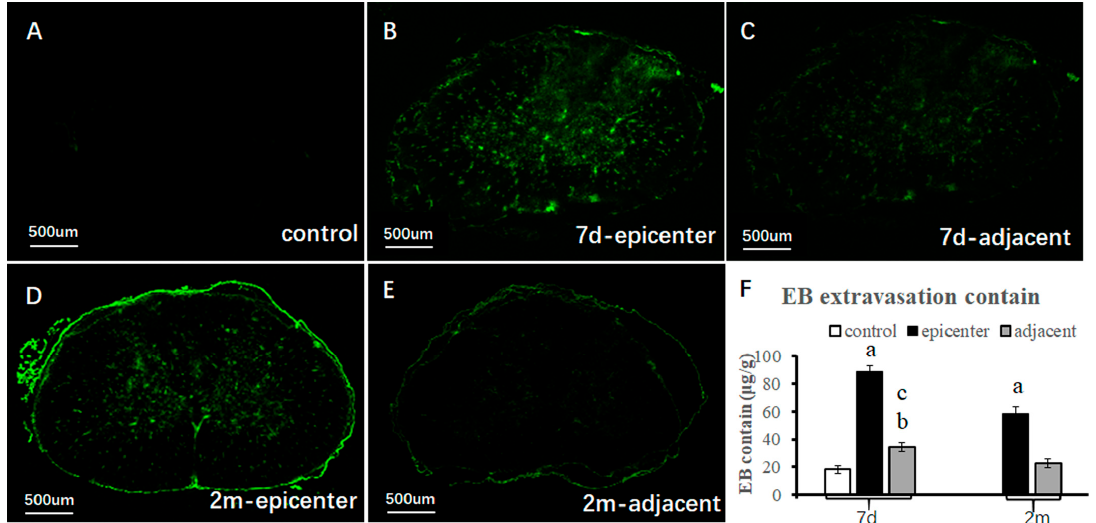
Figure 6. Disruption of BSCB integrity. ( A ) Negative EB fluorescence in control group. ( B ) EB fluorescence widely spread into the GM of the compressive epicenter at the 7th day. ( C ) Obvious decreased EB fluorescence in adjacent level at the 7th day. ( D ) Decreased EB fluorescence in the compressive epicenter at the 2nd month. ( E ) Significantly decreased EB fluorescence in adjacent level at 2nd month. ( F ) EB extravasation content increased significantly in the epicenter and adjacent level at the 7th day, while it decreased at the 2nd month. No significant difference was found between the adjacent level at 2nd month and the control group. “a,b”. compared with control group; “c”, compressive epicenter compared with adjacent level ( p < 0.01).